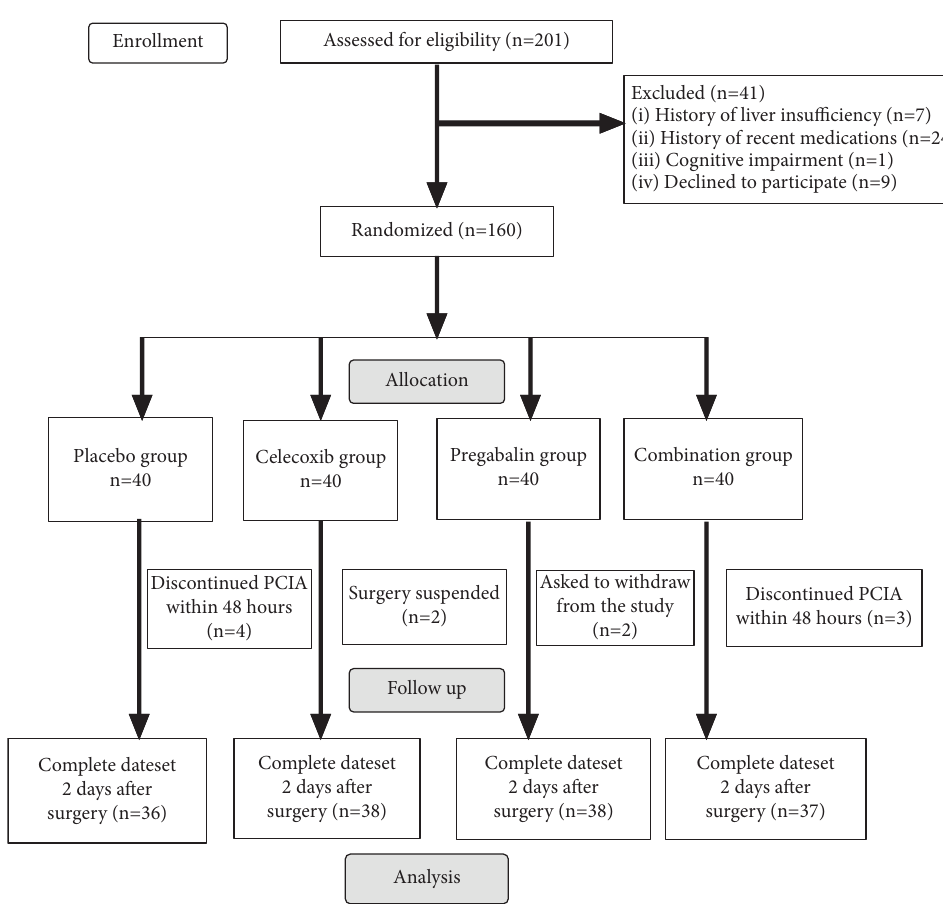
Figure 1: Te CONSORT study participant fow